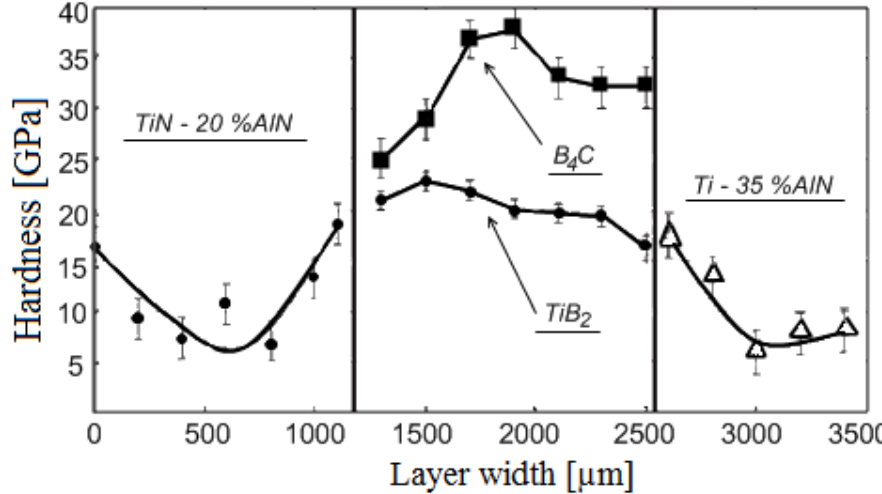
Figure 52. The hardness profile of the composite: TiN-20AlN (1st layer), B (2nd layer), and TiN-35AlN (3rd